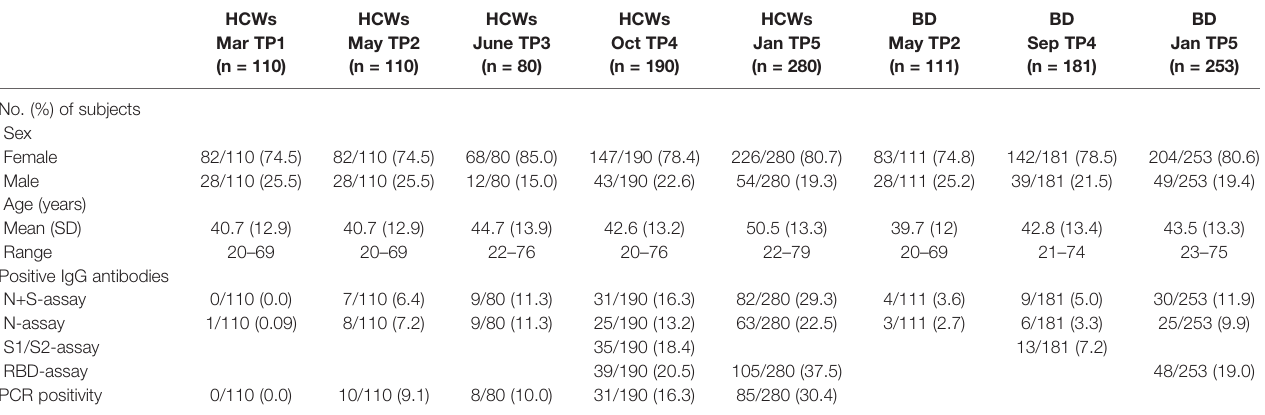
TABLE 1 | Characteristics of participants at every sampling time-point and results from the serological assays and